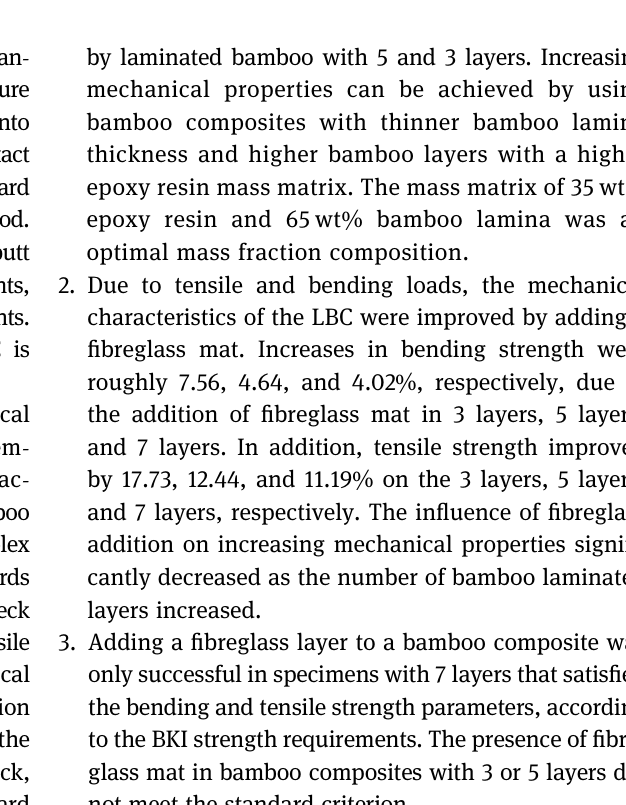
Figure 13: Joint types of laminated composite: ( a ) butt joint, ( b ) scarf joint, ( c ) fi nger joint, ( d ) tongue and groove joint, and ( e ) desk